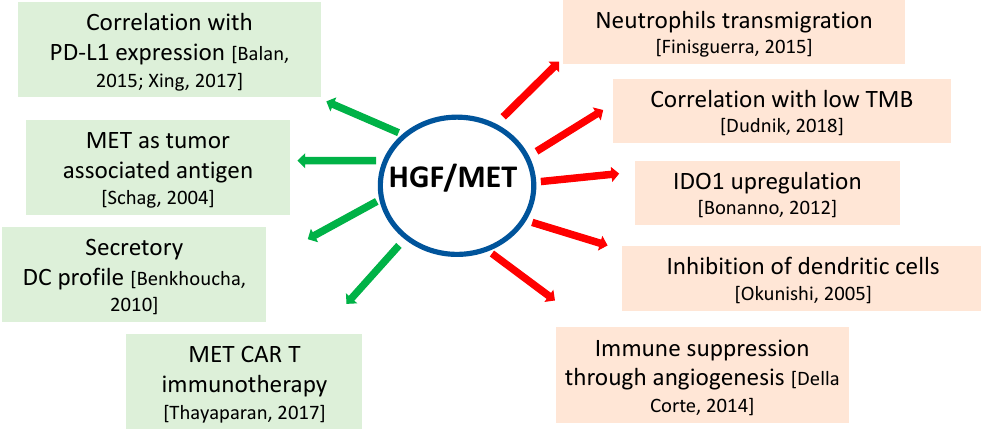
Figure 2. Multiple roles of HGF/MET in cancer immunotherapy. MET CAR T: MET chimeric antigen receptor T cell; IDO1: indoleamine 2,3-dioxygenase 1.